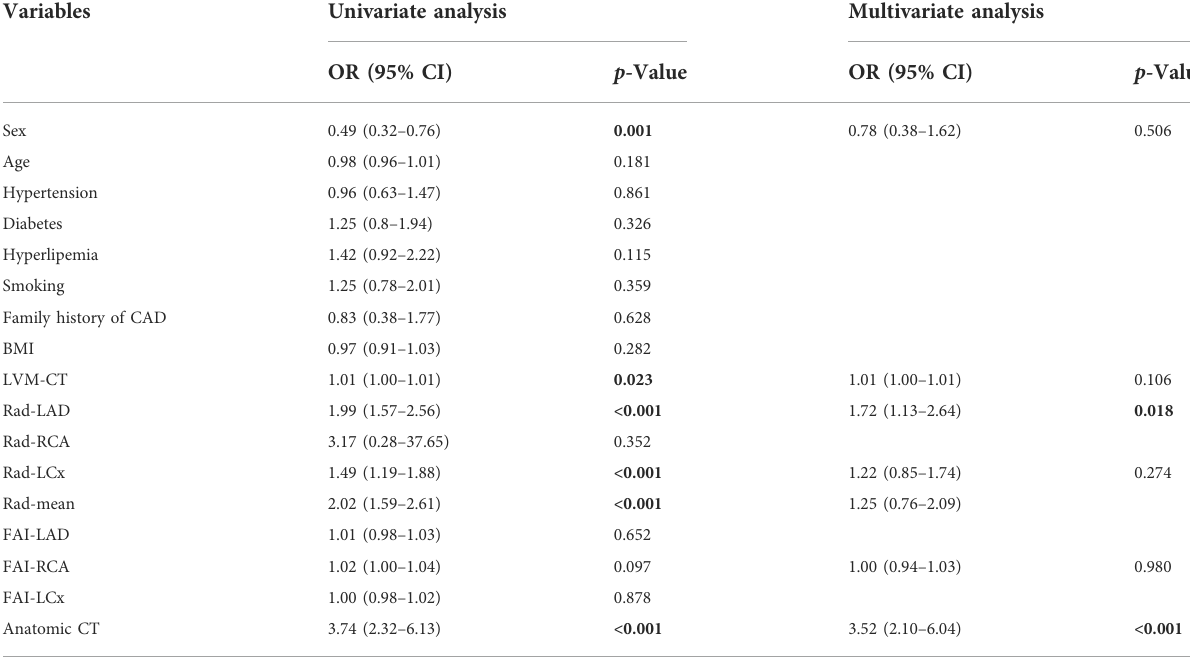
TABLE 4 Logistic regression analysis of discriminating coronary functional ischemia in the whole study population at the patient level.